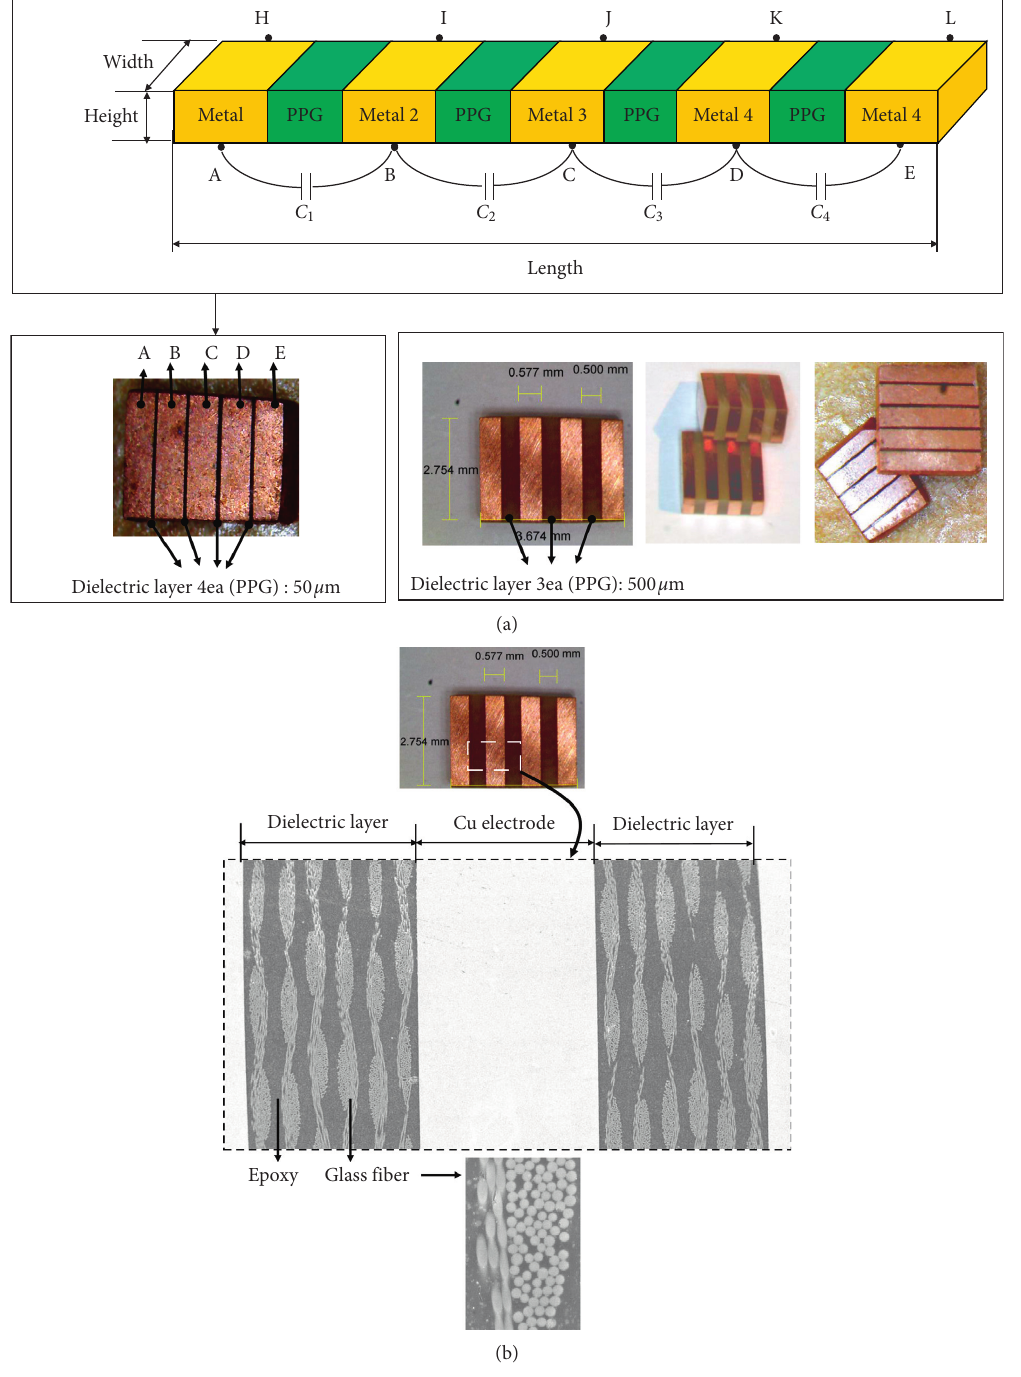
Figure 4: Fabricated horizontal array capacitor having (a) 9ea capacitances with five electrodes and four dielectrics and (b) an impregnated glass fiber of the epoxy as the